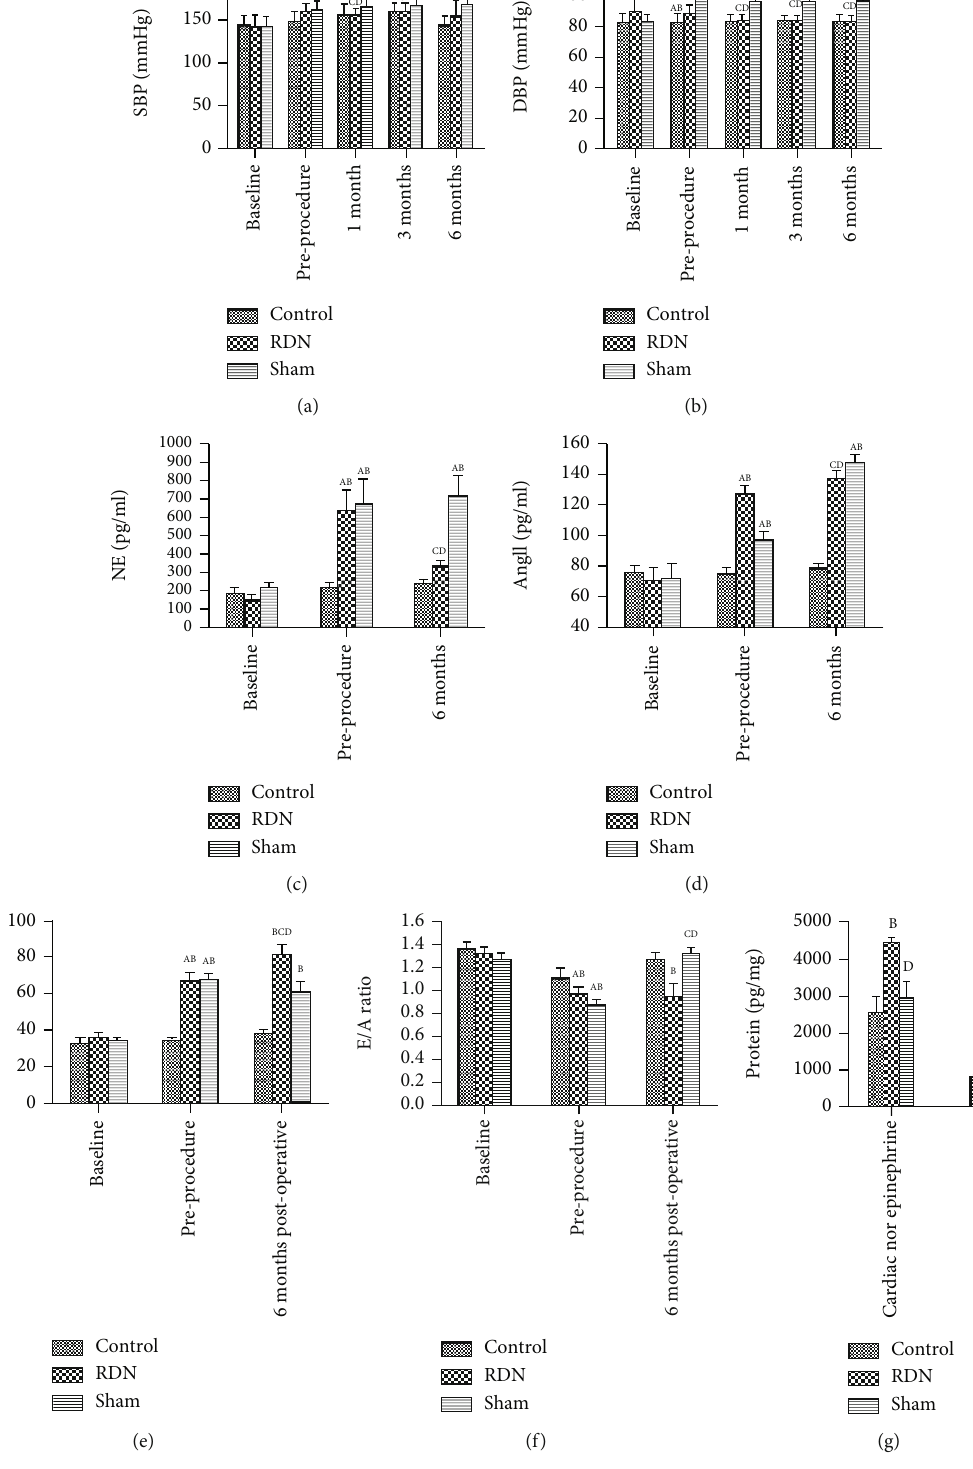
Figure 1: Changes in blood pressure, left ventricular mass (LVM), peak E/A ratio, norepinephrine (NE), and angiotensin II (AngII) in experimental dogs. A Compared with baseline, P < 0 : 05 . B Compared with the control group, P < 0 : 05 . C Compared with the sham group, P < 0 : 05 . D Compared with preprocedure, P < 0 : 05